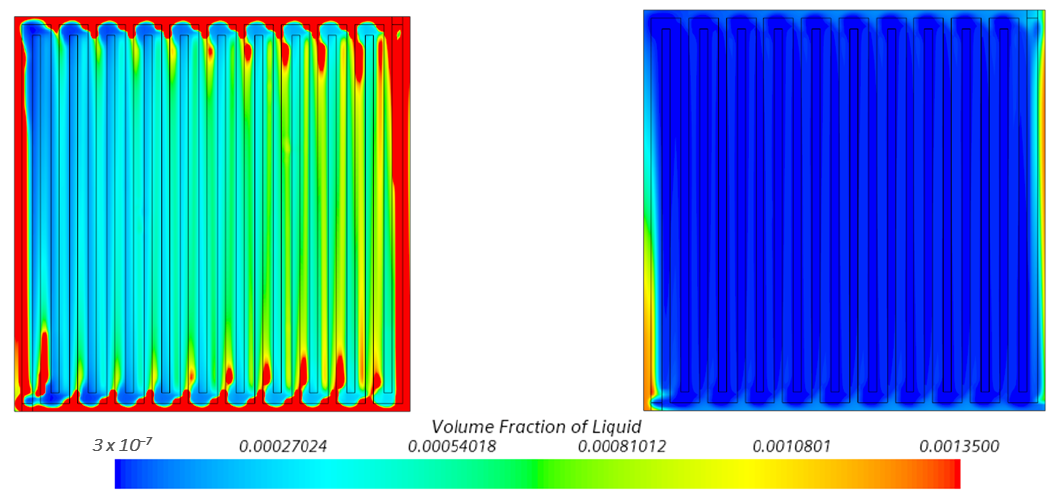
Figure 10. Section views of liquid volume fraction at CCL for the 0.2 V ( left ) and the 0.7 V case ( right ).